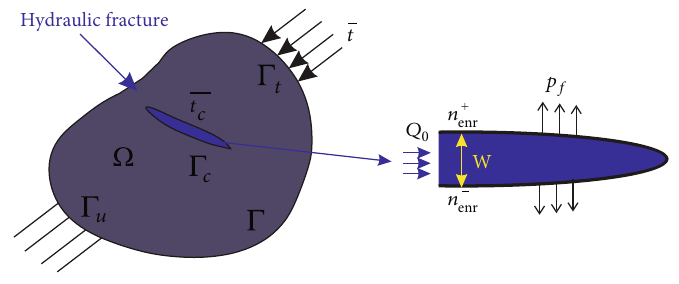
Figure 1: Schematic of linear elastic solid with hydraulic